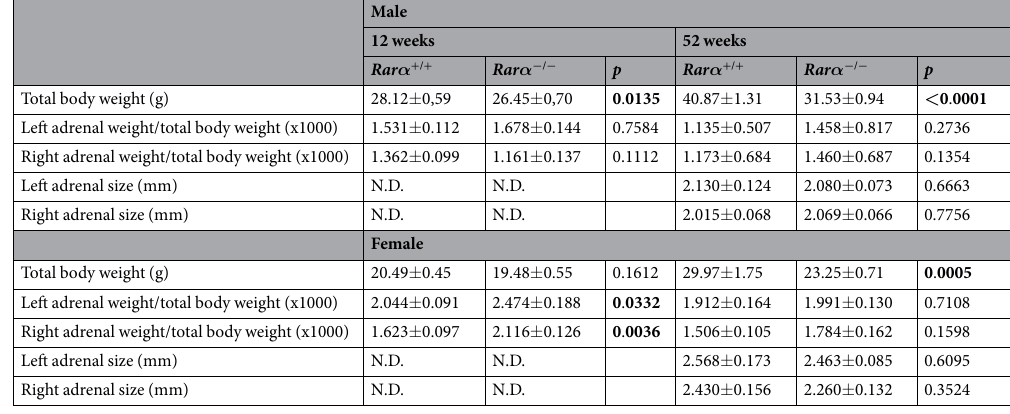
Table 3. Clinical characteristics of 12 and 52 weeks male and female Rar α + / + and Rar α - / - mice. N.D., Not Determined. Quantitative data reported as mean ± SEM and compared with the Mann-Whitney test (p significant if <